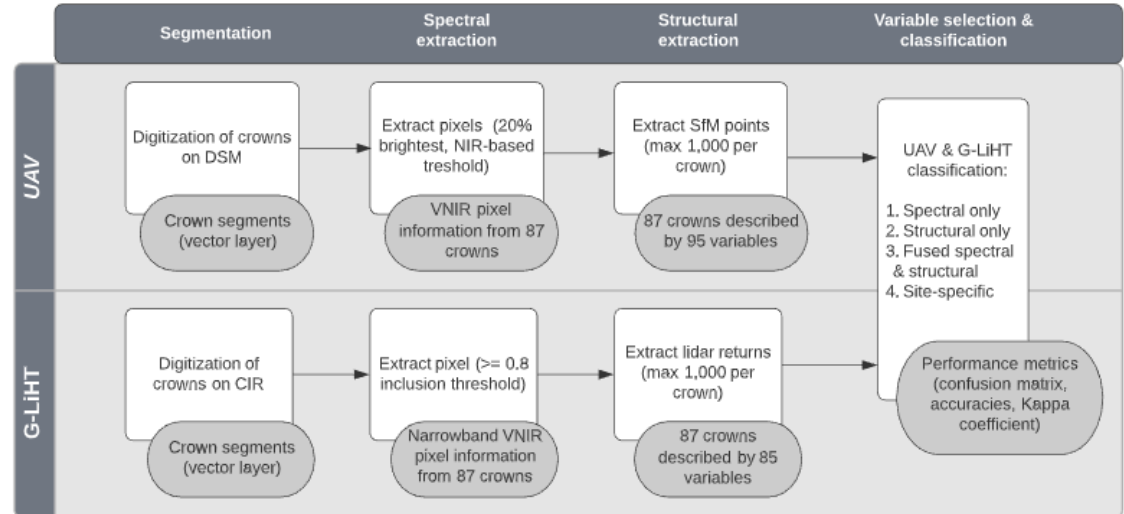
Figure 2. Workflow for data processing, crown delineation, extraction of image and point cloud data, and feature selection and classification. White boxes are processes and gray boxes are data products.